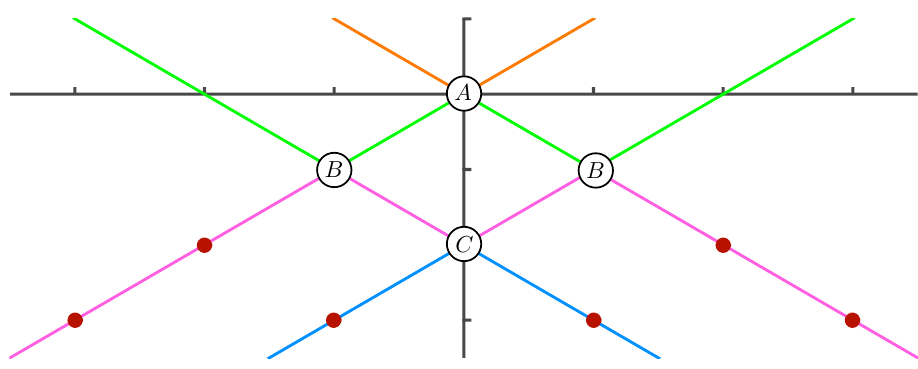
Figure 13 . Contributions to the Regge-limit four-point correlator of Conformal Fishnet The- ory. Cuts A - C occur at the intersections of the trajectories and the calculations correspond to figures 10, 11 and 12. The additional maroon dots occur at the poles of the cosecant function. As hoped, all terms come from localized points or short cuts on the Regge